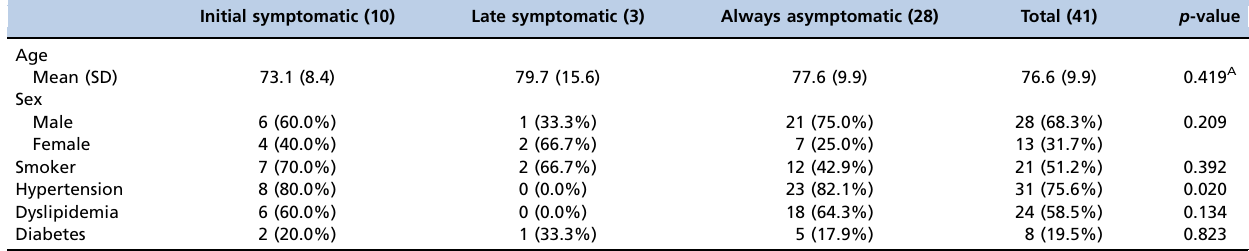
Table 1 - Clinical characteristics of the sample by group. Initial symptomatic (10)